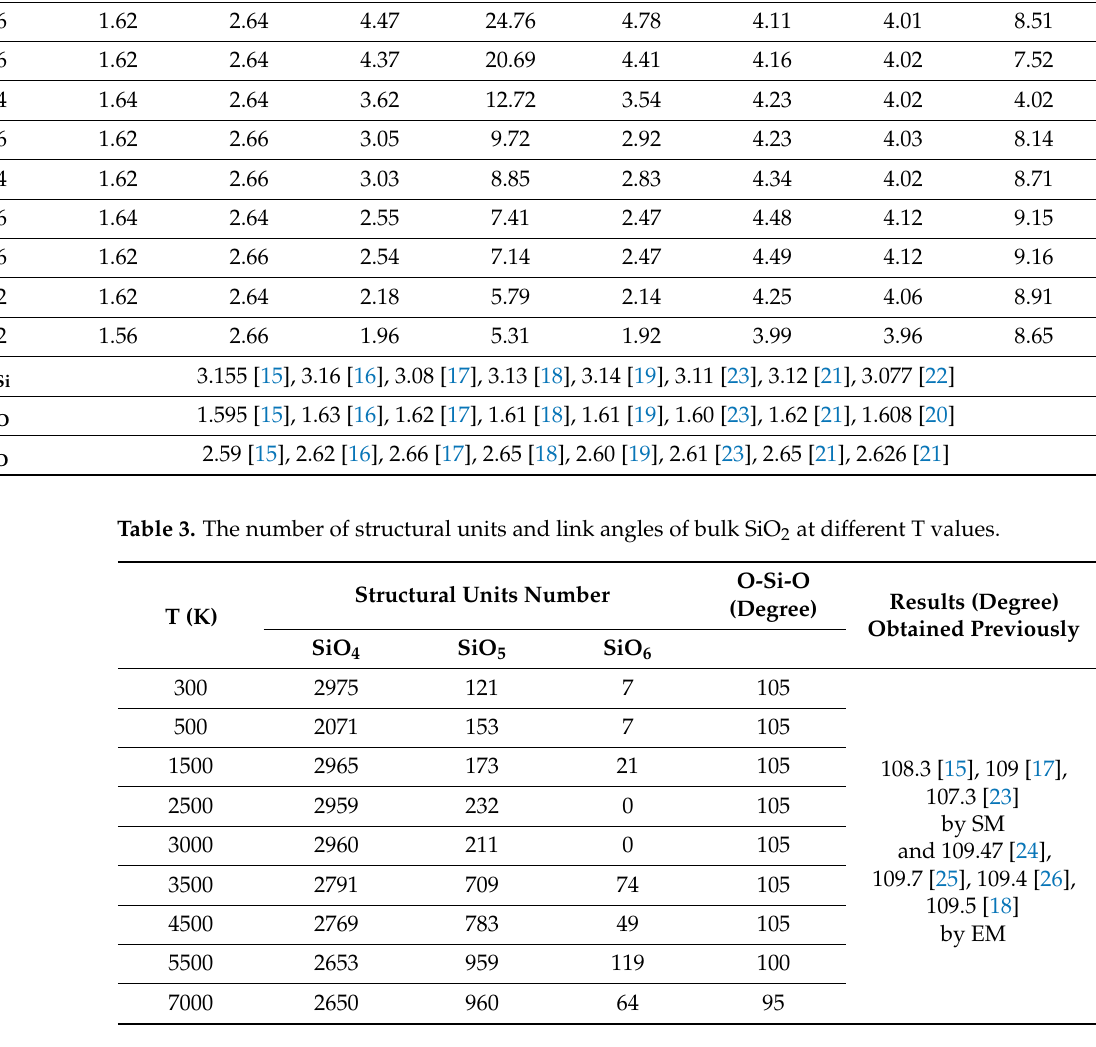
Table 2. The structural characteristic quantity of bulk SiO 2 at different T values.